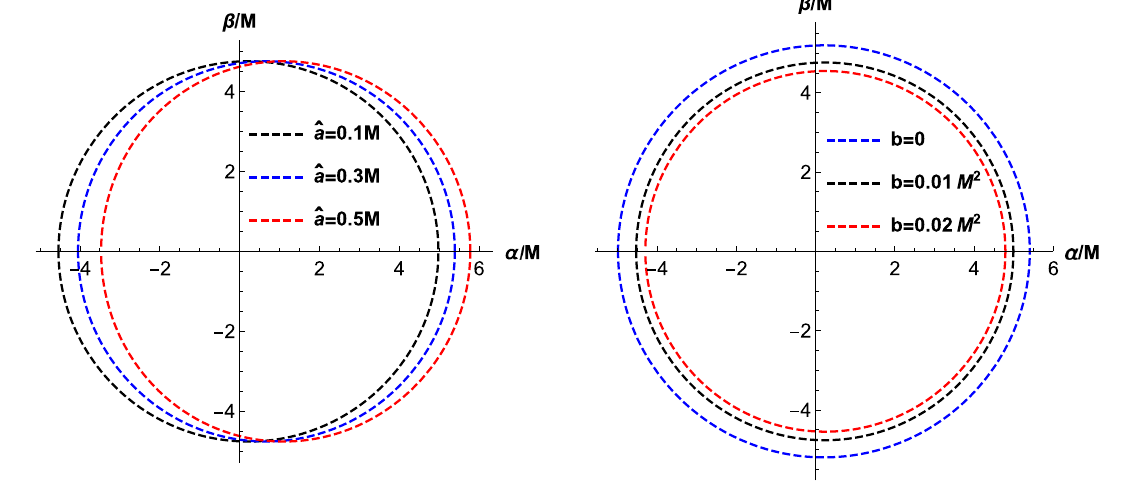
Fig. 15 The left panel gives shapes of the shadow for various values of ˆ a with b = 0 . 01 M 2 , (cid:2) = 0 . 1 and θ = π/ 2. The right panel gives shapes of the shadow for various values of b with a = 0 . 1 M , (cid:2) = 0 . 1, and θ = π/ 2